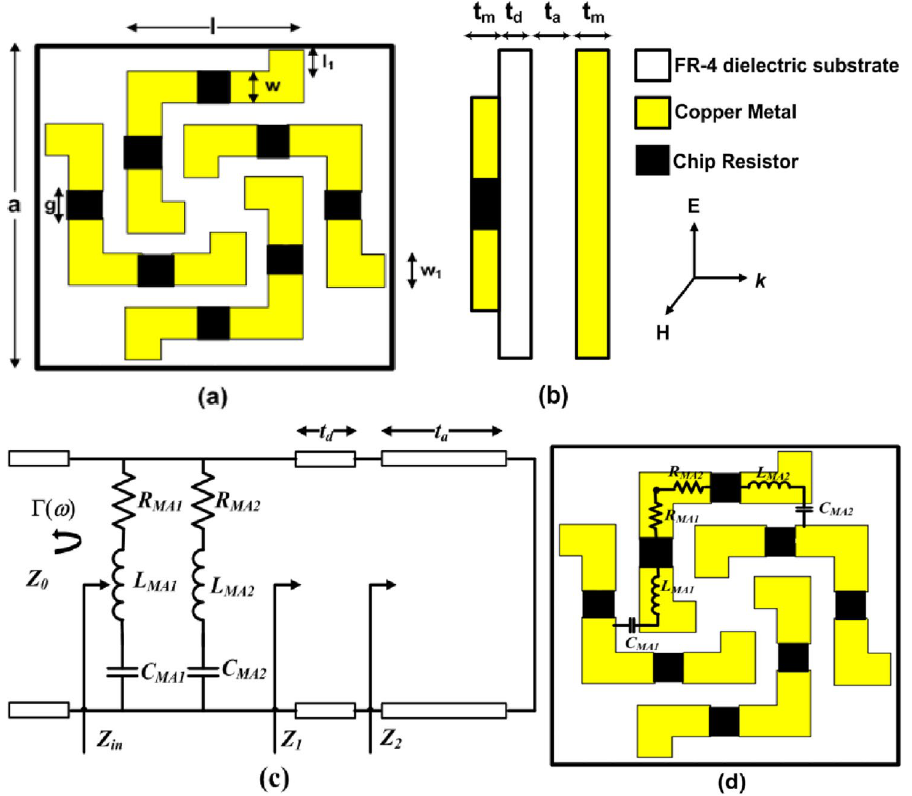
Figure 1. Unit cell geometry of the proposed absorber: ( a ) top view and ( b ) side view and ( c ) equivalent circuit model of the proposed metasurface absorber and ( d ) RLC modelling of top resistive